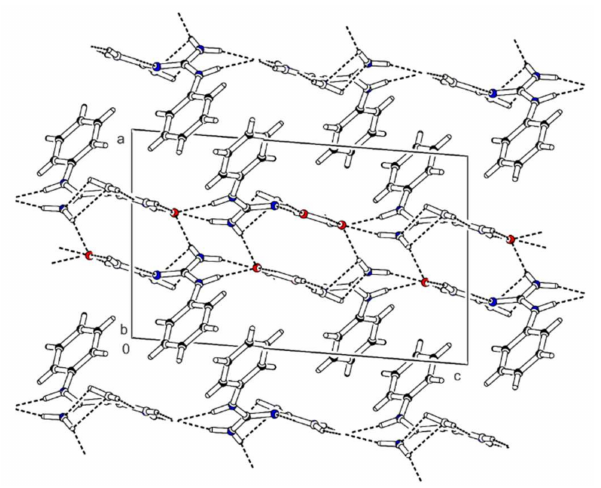
Figure 3. Packing scheme of phbiguaHCO 3 (view along the b axis direction); dashed lines indicate hydrogen bonds, solid lines indicate unit cell.